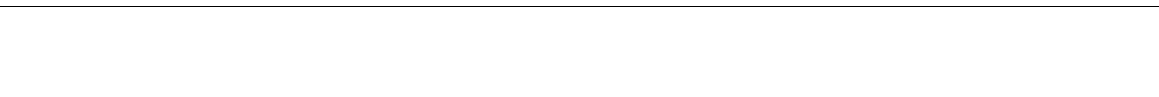
Frontiers in Neurology |